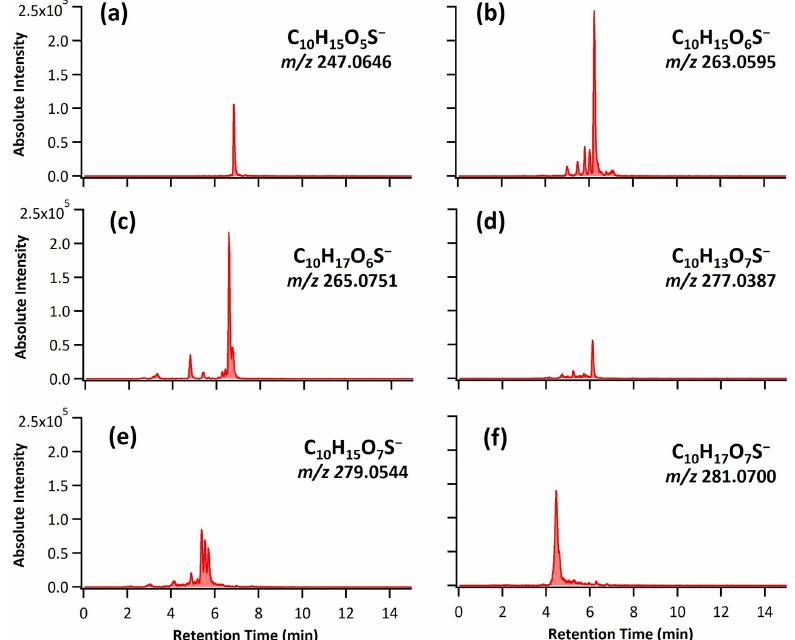
Figure 2. The extracted ion chromatograms (EICs) of the ions associated with reaction products formed upon heterogeneous OH oxidation of α pOS-249 at the highest OH exposure by HPLC/ESI-QToF-MS with mass tolerance of ± 5ppm to their theoretical masses (shown).